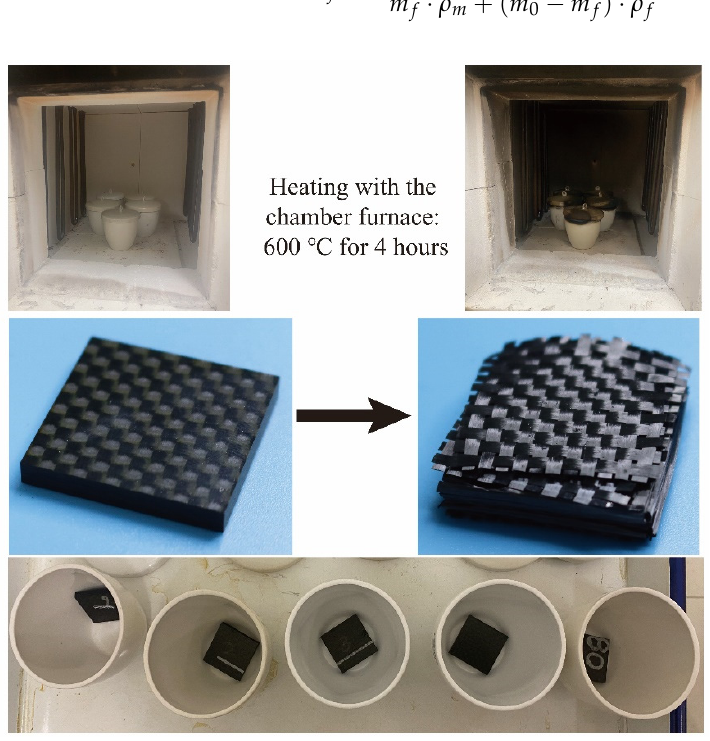
Figure 10. Thermal ablation experiments on the specimens of T300/Cycom970 fabric laminates. Table 3. Results of the thermal ablation experiments. Specimen